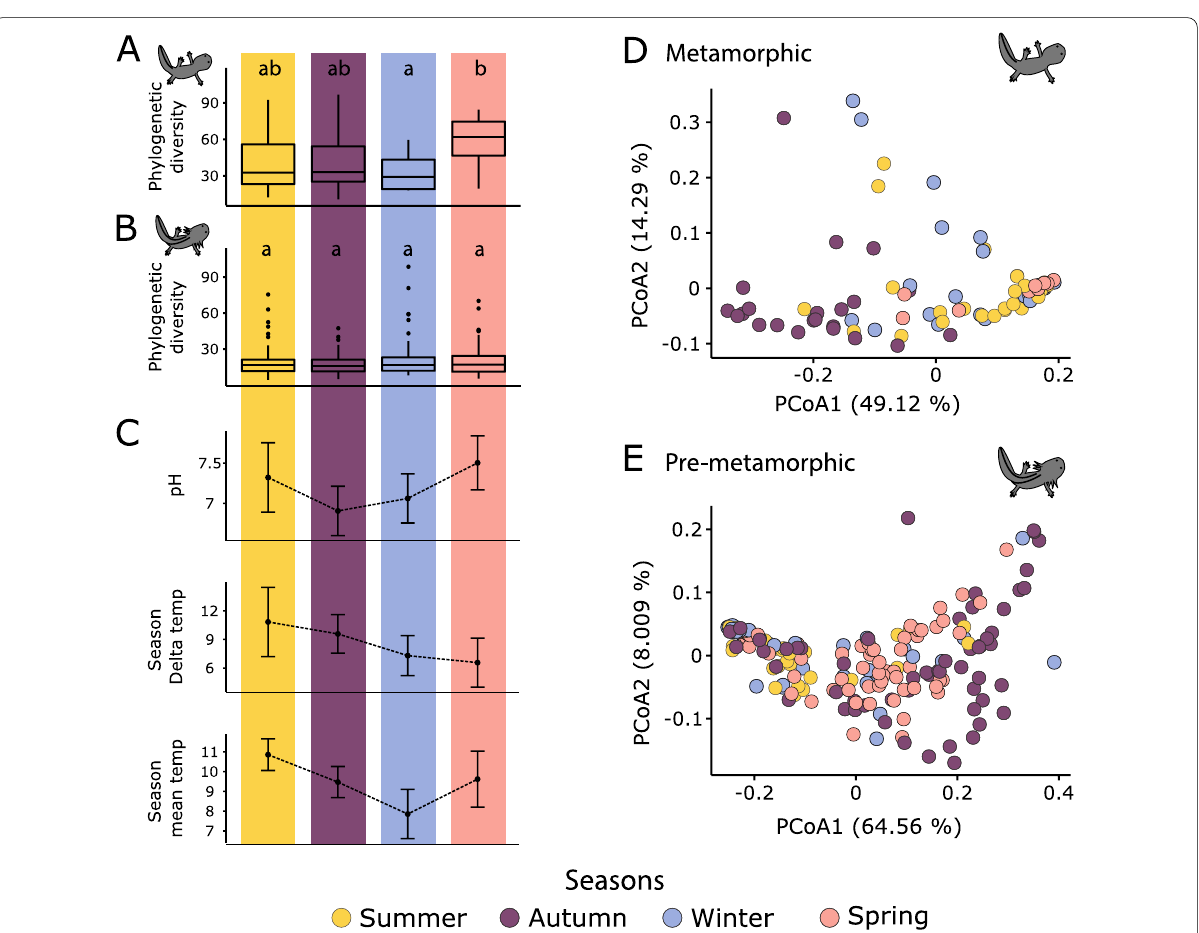
Fig. 3 Seasonal influence over metamorphic and pre‑metamorphic skin bacterial diversity. A Phylogenetic diversity (PD) across seasons in metamorphic samples. Letters a–d indicate statistically significant comparisons. B PD across seasons in pre‑metamorphic samples. C Seasonal variation of pH, delta temperature and mean temperature of the stream water. D Principal coordinate analysis (PCoA) based on weighted UniFrac distances across seasons of metamorphic samples. E PCoA based on weighted UniFrac distances across seasons in pre‑metamorphic samples. Circles in D and E panels are color‑coded by